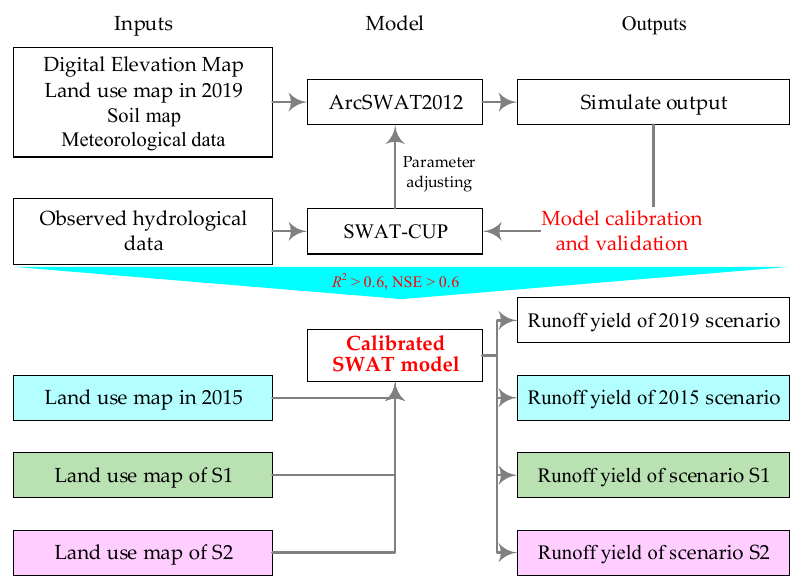
Figure 4. The flowchart of the SWAT model in the study.